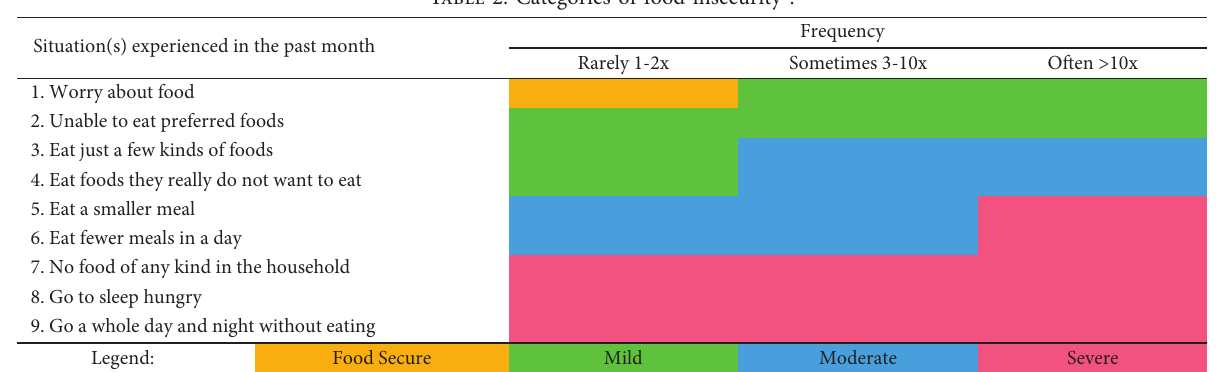
Table 2: Categories of food insecurity 1